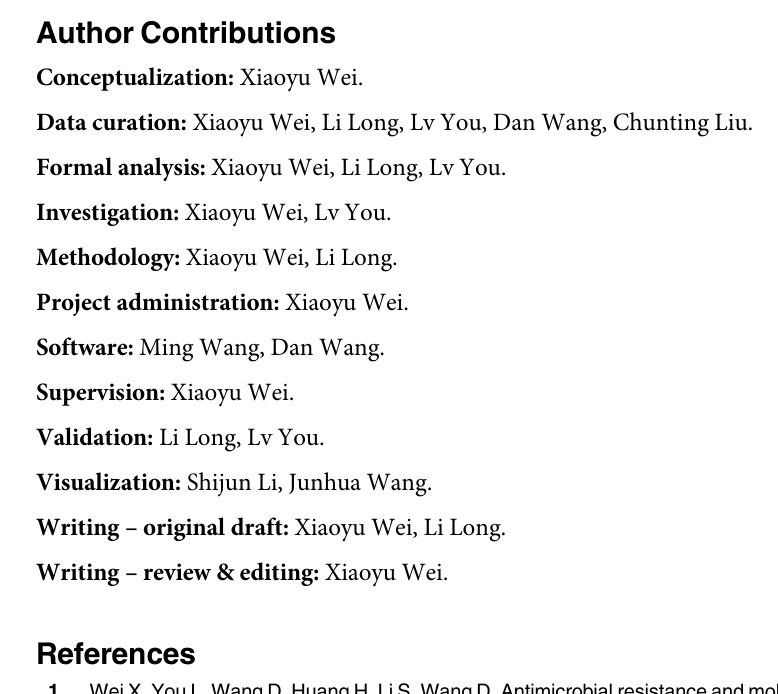
S3 Table. The serotype distribution of human Salmonella isolates in nine cities (prefec- tures) of Guizhou